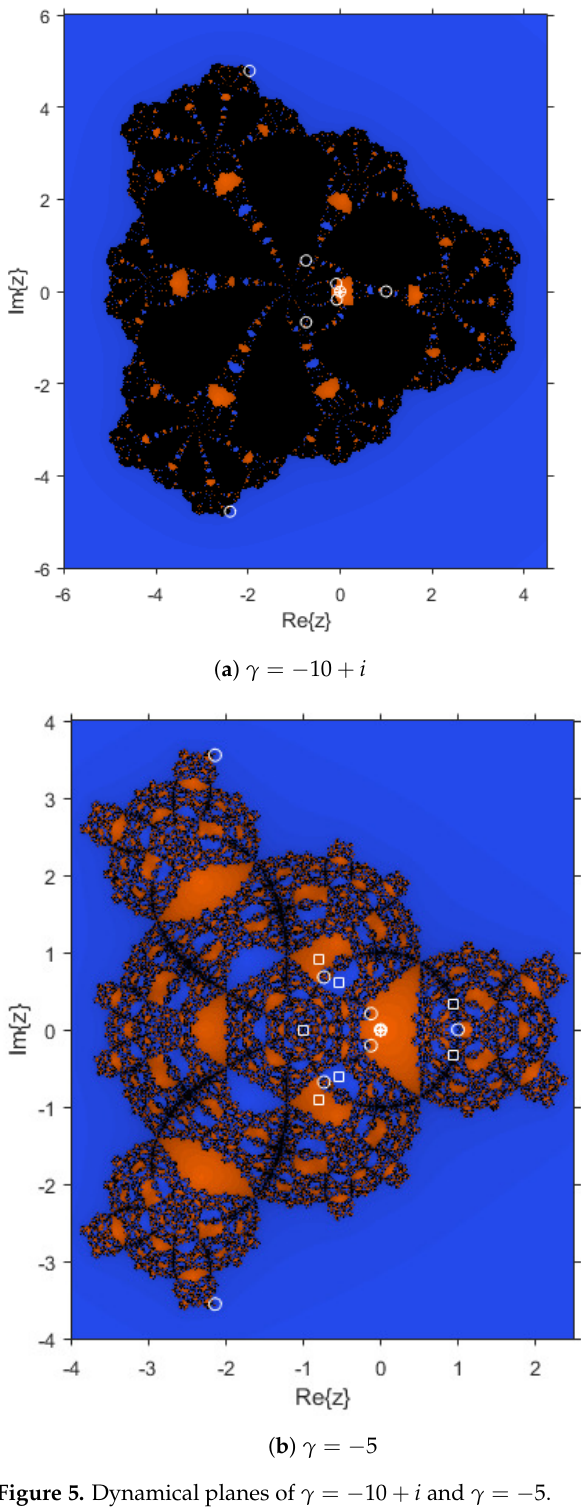
Figure 5. Dynamical planes of γ = − 10 + i and γ = −